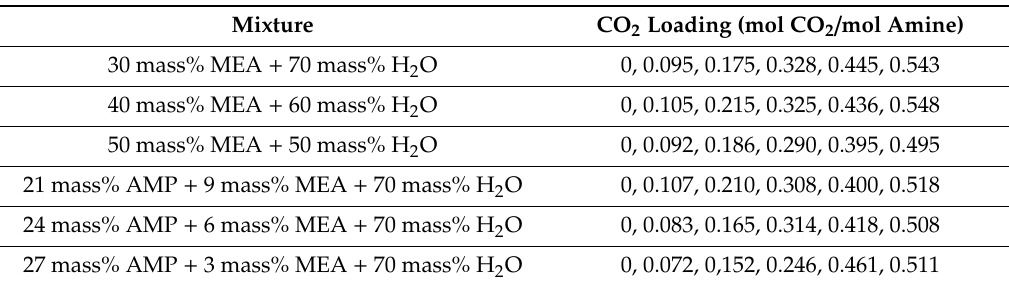
Table 2. Characteristics of the amine